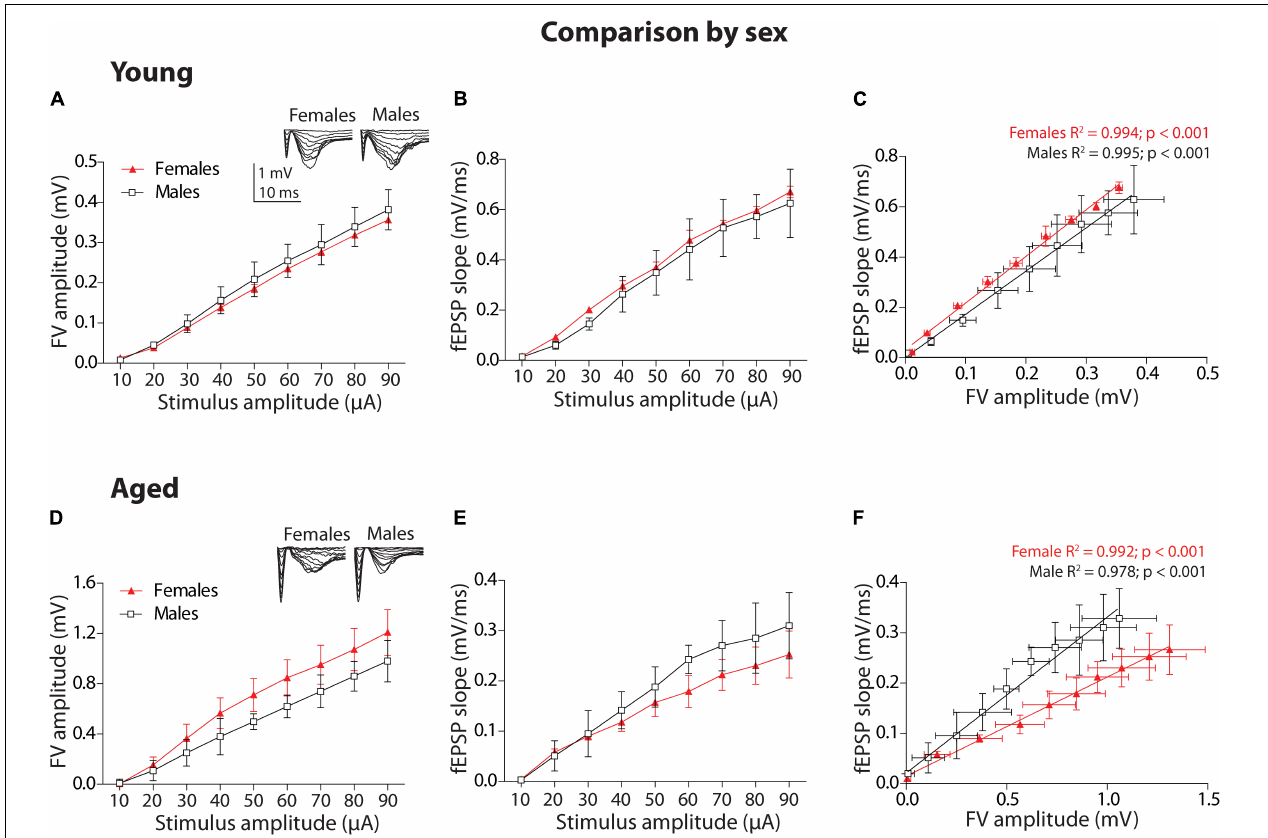
FIGURE 1 | Sex comparison of the synaptic transmission basal parameters at Schaffer collateral-CA1 synapse of young and aged female and male degus. (A,B) Input–output relationship between different stimulus intensity (10–90 µ A) and the fiber volley amplitude (A) or the field excitatory postsynaptic potential (fEPSP) slope , n = 5 ) and aged degus ( D,E , 60–84 months old; n = 5 , n = 5 ). The insets are representative recordings (B) in young degus ( A,B , 12–24 months old; n = 5 obtained by this protocol, showing the FV volley and fEPSPs evoked at increasing stimulation pulses (scale: 1 mV, 10 ms). (C,F) Correlation between fiber volley and ♀ ♂ ♀ ♂ fEPSP slope adjusted with a linear regression (values on the graph) in young (C) and aged (F) female and male degus. Two-way ANOVA followed by the Bonferroni post hoc test was used to analyze statistical differences in (A,B,D,E) ; for (C,F) , we used an analysis of covariance (ANCOVA) test to analyze linear regression differences. Each symbol corresponds to the sex-age treatment group data represented as the mean ± SEM. At least three slices from each animal were considered replicates and averaged together. Black and red symbols represent the comparison by